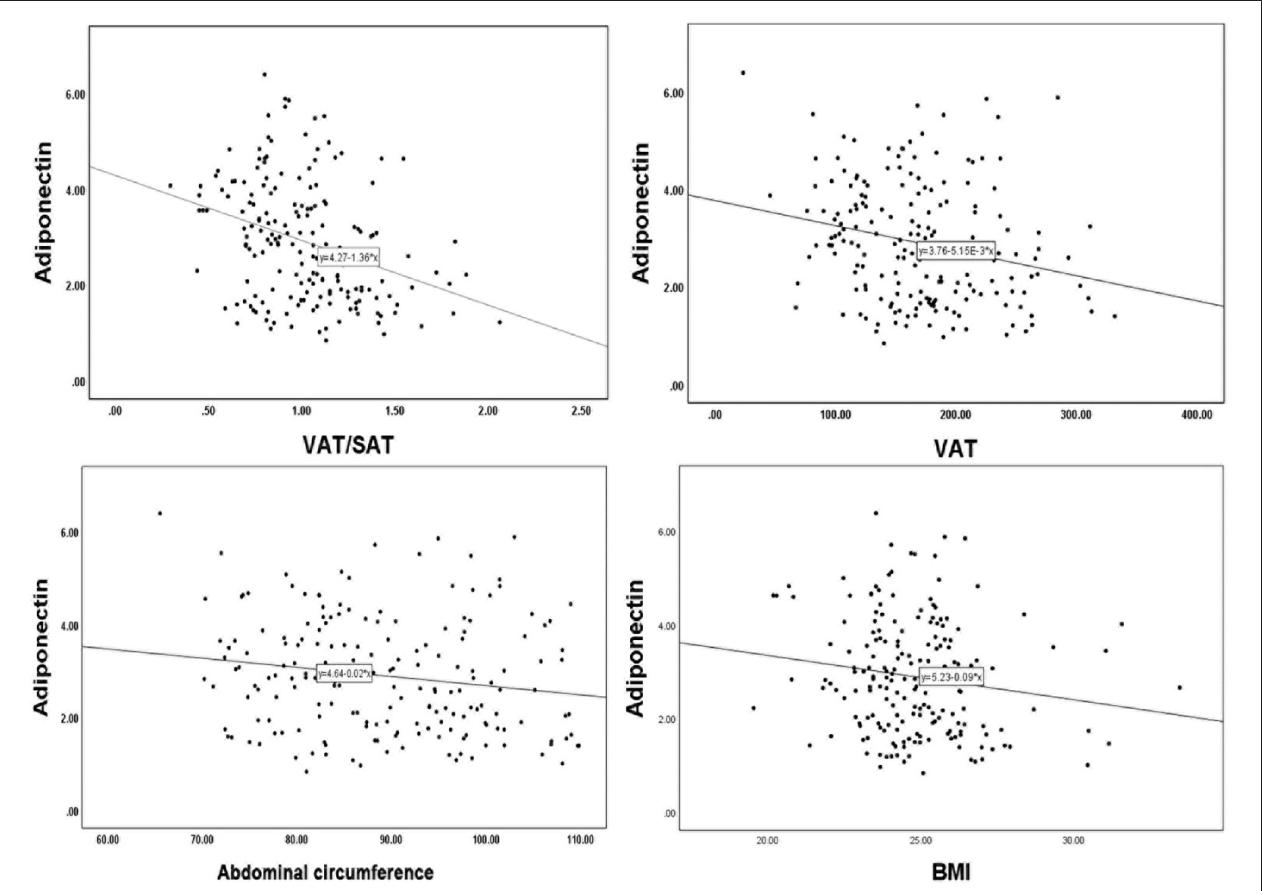
FIGURE 2 | Linear correlation analysis of adiponectin with VAT/SAT, VAT, abdominal circumference, BMI. VAT, visceral adipose tissue; SAT, subcutaneous adipose tissue; BMI, body mass index.